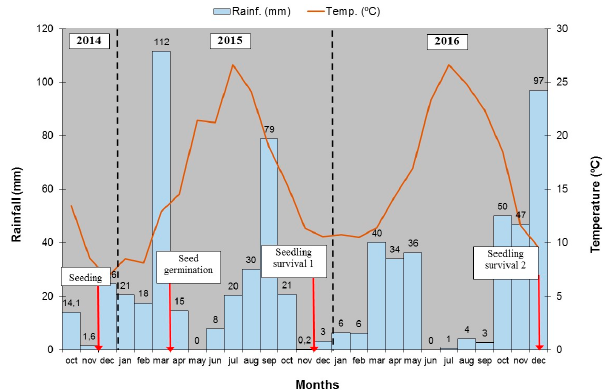
Figure 2. Climate diagram with the data recorded (research period October 2014–December 2016) at the weather station (Meteodata-3016C) in the experimental area. The diagram shows monthly precipitation (left ordinate, and bars) and average temperature (right ordinate, and line). Red arrows indicate the main observation dates: seeding, seed germination and two seedling inventories.